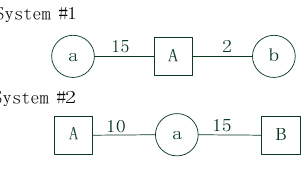
Figure 1. Example systems with simulated data. The systems include facility units a , b and population units A , B . The numbers between facility and population represent travel